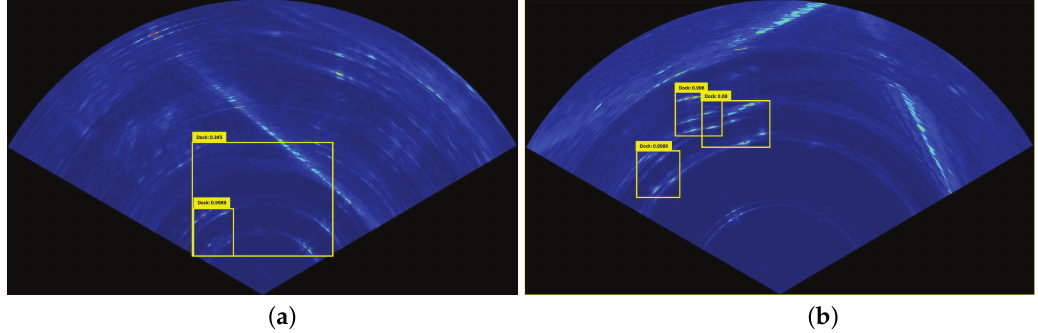
Figure 10. In ( a ) one far too wide box is identified for the same object, it needs to be removed and in ( b ) both docks on the top are identified, however, the bounding box is far too wide for one of